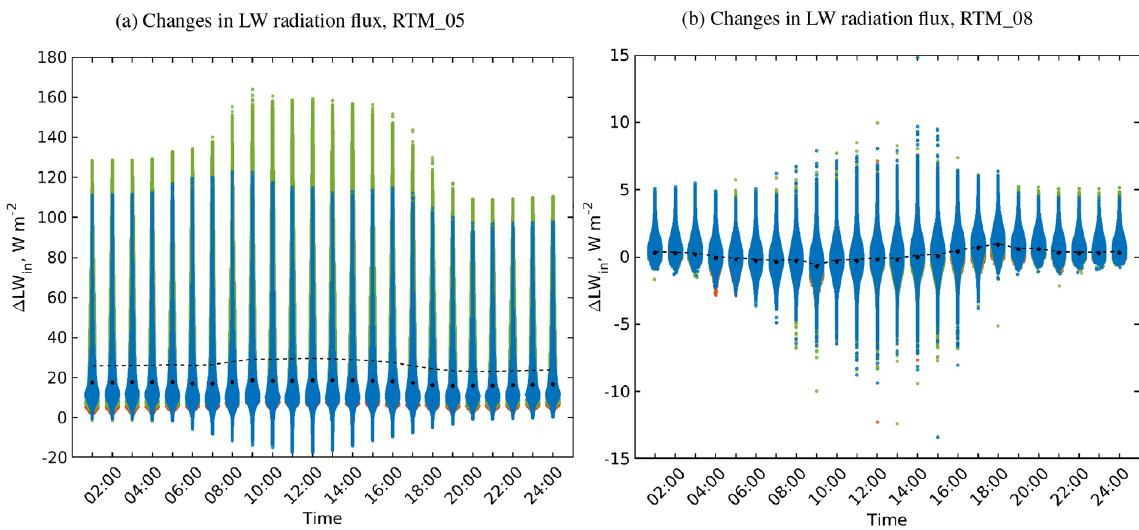
Figure 19. Changes in the received LW irradiance for the surfaces of the realistic urban configuration when considering (a) the vegetation interaction with LW radiation (RTM_05) and (b) the multiple reflections (RTM_08). Violin, mean, and median colours are used in the same way as those in Fig. 5.